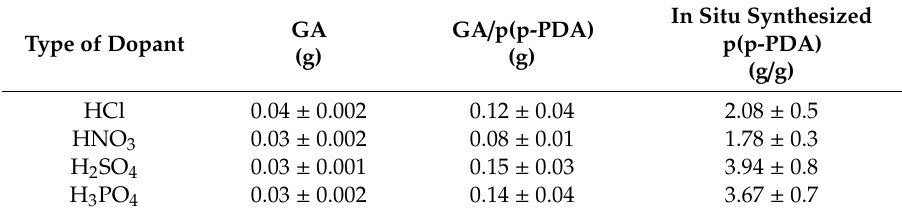
Table 1. The gravimetric amounts of in situ synthesized p(p-PDA) polymers within GAs.